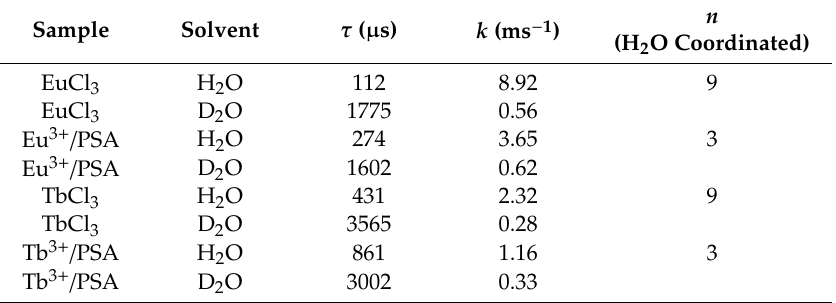
Table 1. Lifetimes ( τ ), decay constant ( k ) and number of coordinated water molecules ( n ) of Eu 3 +